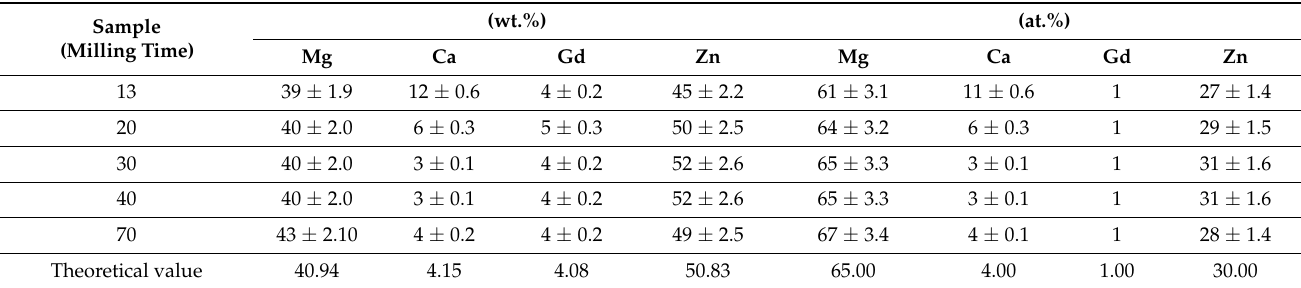
Table 3. EDS (energy-dispersive spectroscopy) results from the Mg 65 Zn 30 Ca 4 Gd 1 powder alloy samples for 13, 20, 30, 40, and 70 h,